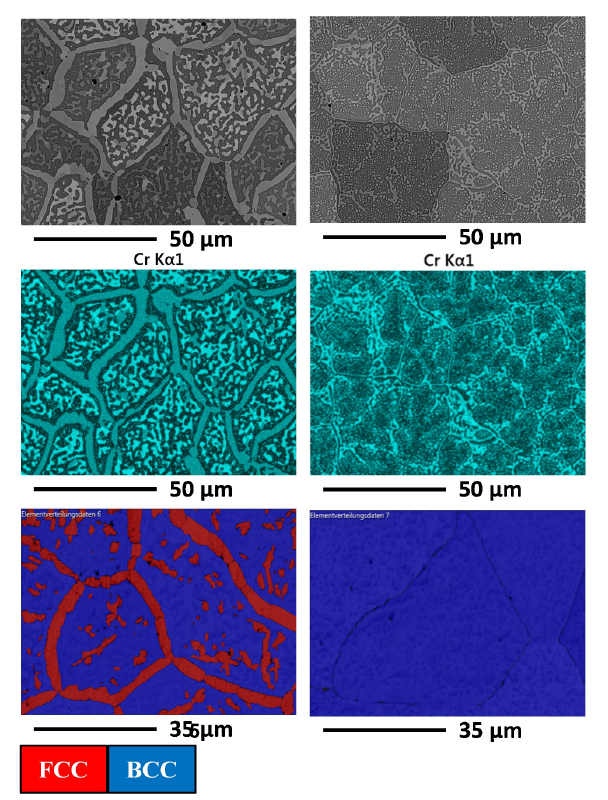
FIGURE 10 | EDS Cr maps and EBSD phase maps of sample positions 4 (left) and 6 (right).